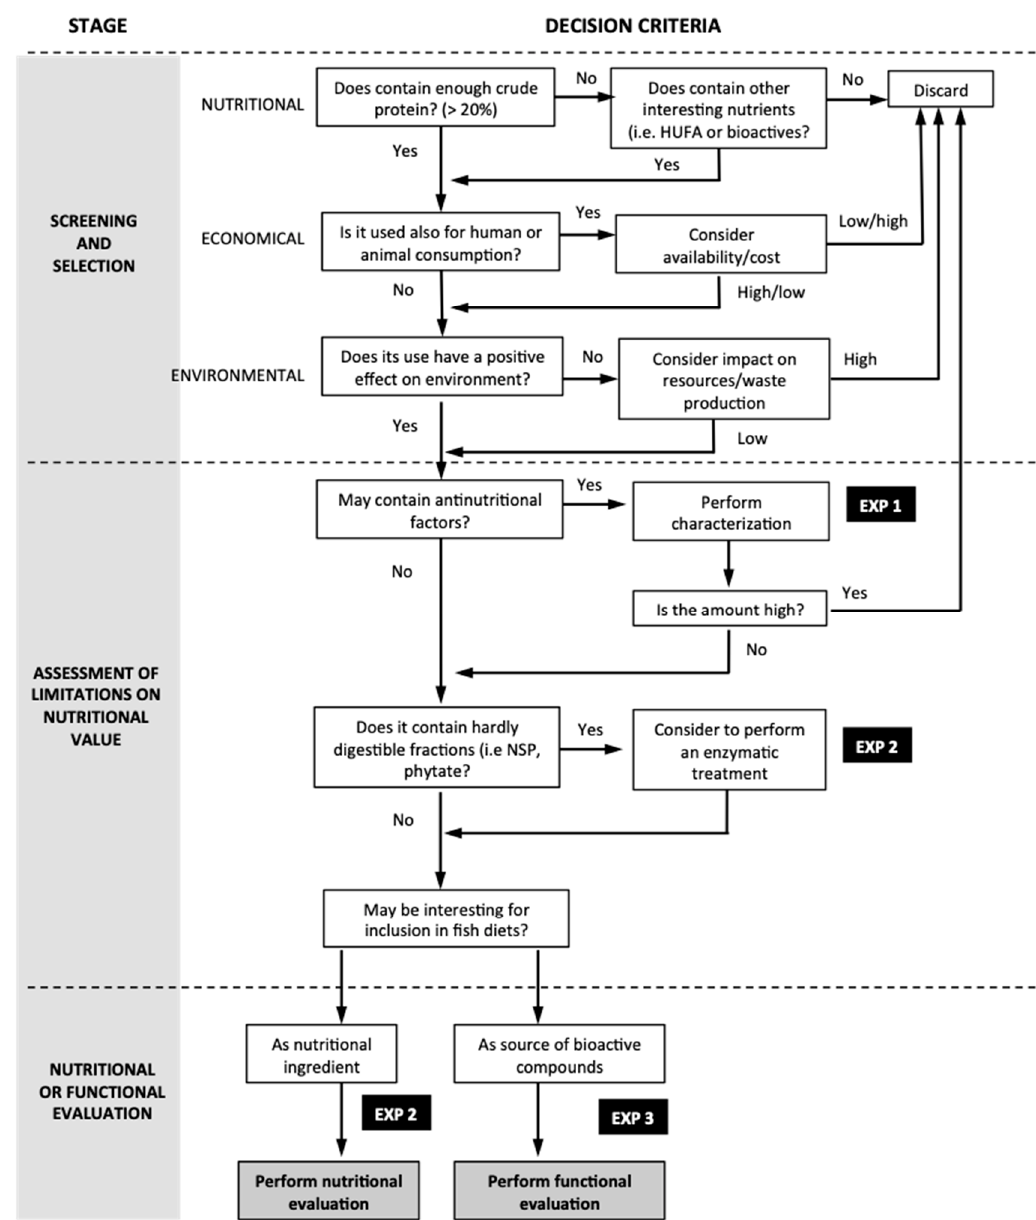
Figure 1. Flow diagram used to design the experiments developed in the present study.